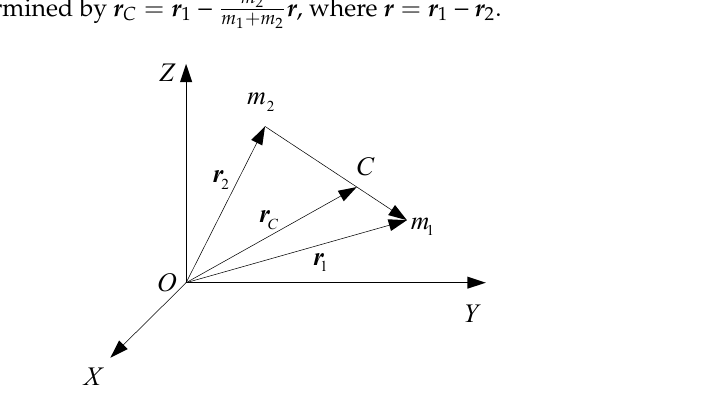
Figure 1. The two-body motion model used in this study. r is the position vector.